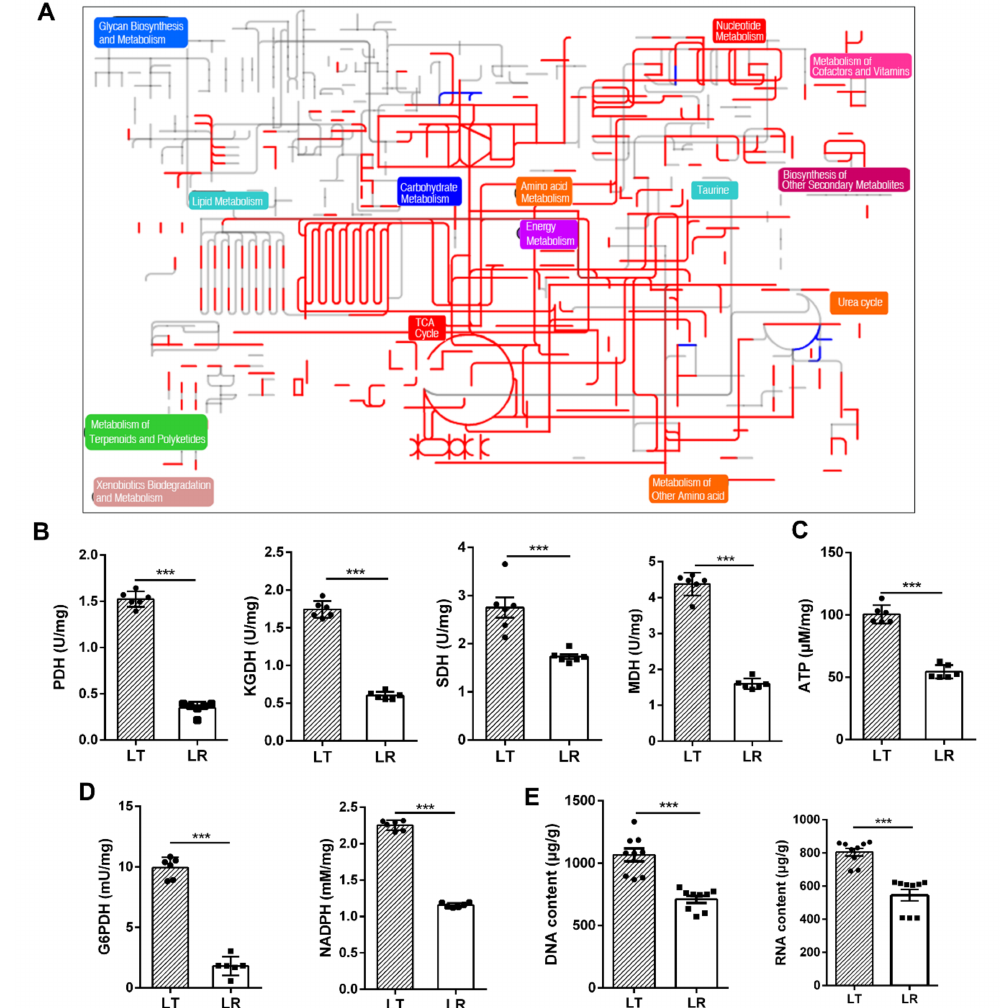
Figure 5. Comparative metabolic pathway analysis between LT and LR. ( A ) Analysis of the porcine metabolic profiles provides a better insight into the effects of 54 significant metabolites ( p < 0.01) and enzyme activity. Based on the KEGG compound (http://www.kegg.jp/kegg/compound/) (accessed on 6 April 2021), metabolic network pathways are further analyzed with iPath2.0 (http: //pathways.embl.de/iPath2.cgi) (accessed on 6 April 2021). Red line represents an increase in LT groups; blue line represents an increase in LT groups. ( B ) The activity of KGDH, PDH, MDH, and SDH in LL tissues of LT and LR. ( C ) ATP measurement in LL tissues of LT and LR. ( D ) The activity of G6PDH and the measurement of NADPH. ( E ) The content of DNA and RNA per unit mass of LL tissue metabolites in both pathway enrichment analysis and OPLS-DA. Asterisks (*) indicate levels of statistical significance. *** p <